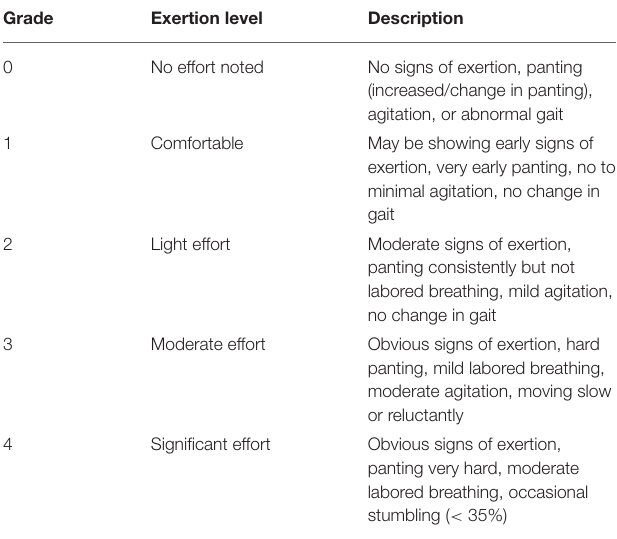
TABLE 5 | Canine perceived exertion scale.